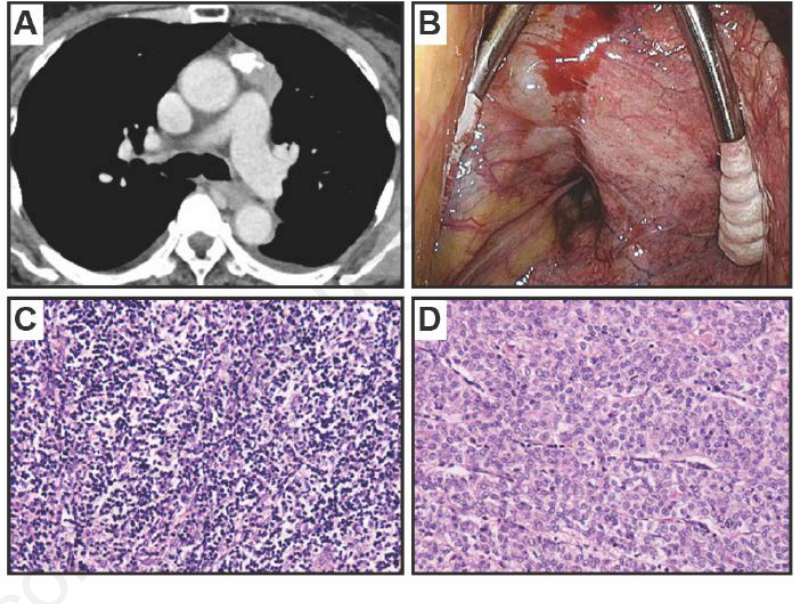
Figure 1. A) Chest computed tomography showing an anterior mediastinal tumor with calcification. The size of the tumor was 39×17×60 mm. B) Surgical view of the anterior mediastinum in the left cavity. There is direct invasion of the left lung by the tumor. C) and D) Microscopic images of the tumor (hematoxylin and eosin stain, high-power field). The final diagnosis was invasive thymoma, with a histological subtype of World Health Organization type AB. The type A area is shown in (C) and the type B area in (D).